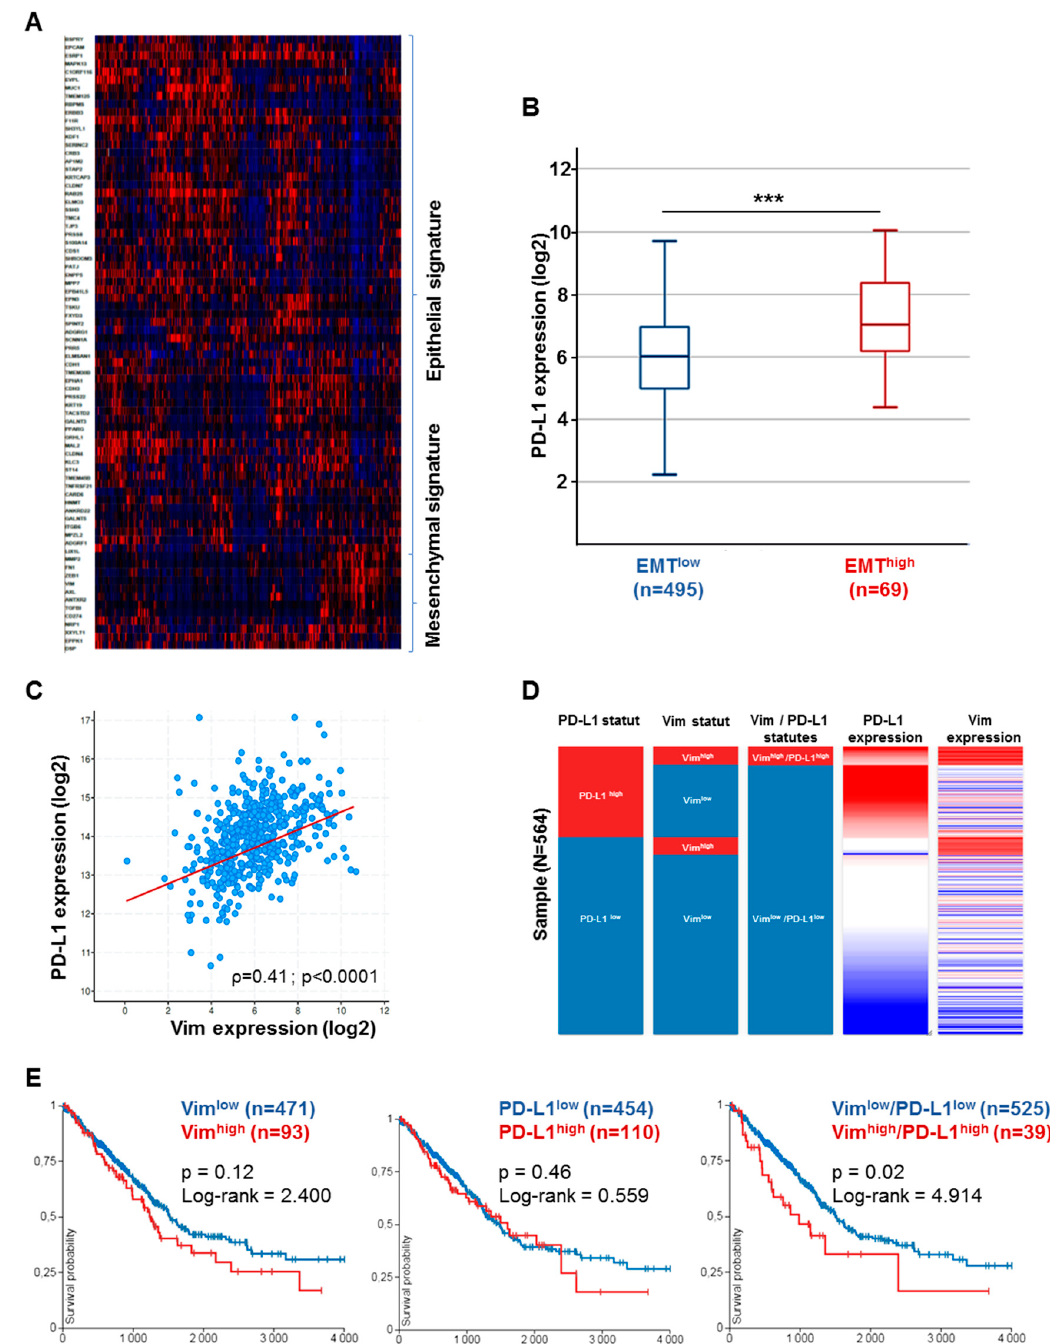
Figure 3. The epithelial–mesenchymal transition signature correlates with PD–L1 expression in Tumor Cancer Genome Atlas Lung Adenocarcinoma (TCGA–LUAD) cohort. ( A ) Heat map showing the di ff erential gene expression by epithelial–mesenchymal features in TCGA–LUAD cohort. ( B ) PD–L1 expression is higher in mesenchymal-types tumors. Tumors with epithelial phenotype (EMT low ) ( n = 495) expressed lower mRNA CD274 level than tumors with mesenchymal features (EMT high ) ( n = 63). *** p < 0.001. ( C ) PD–L1 correlates with vimentin expression in TCGA cohort. Data are showed with dot-plots with log2 scale and analyzed with spearman regression test. ( D ) Tumor repartition in LUAD cohort according to PD–L1 and / or vimentin status. ( E ) Survival analysis according to vimentin, PD–L1 expressions and both Vim / PD–L1 co-expression. Overall survival probability by time (days) represented with Kaplan–Meier